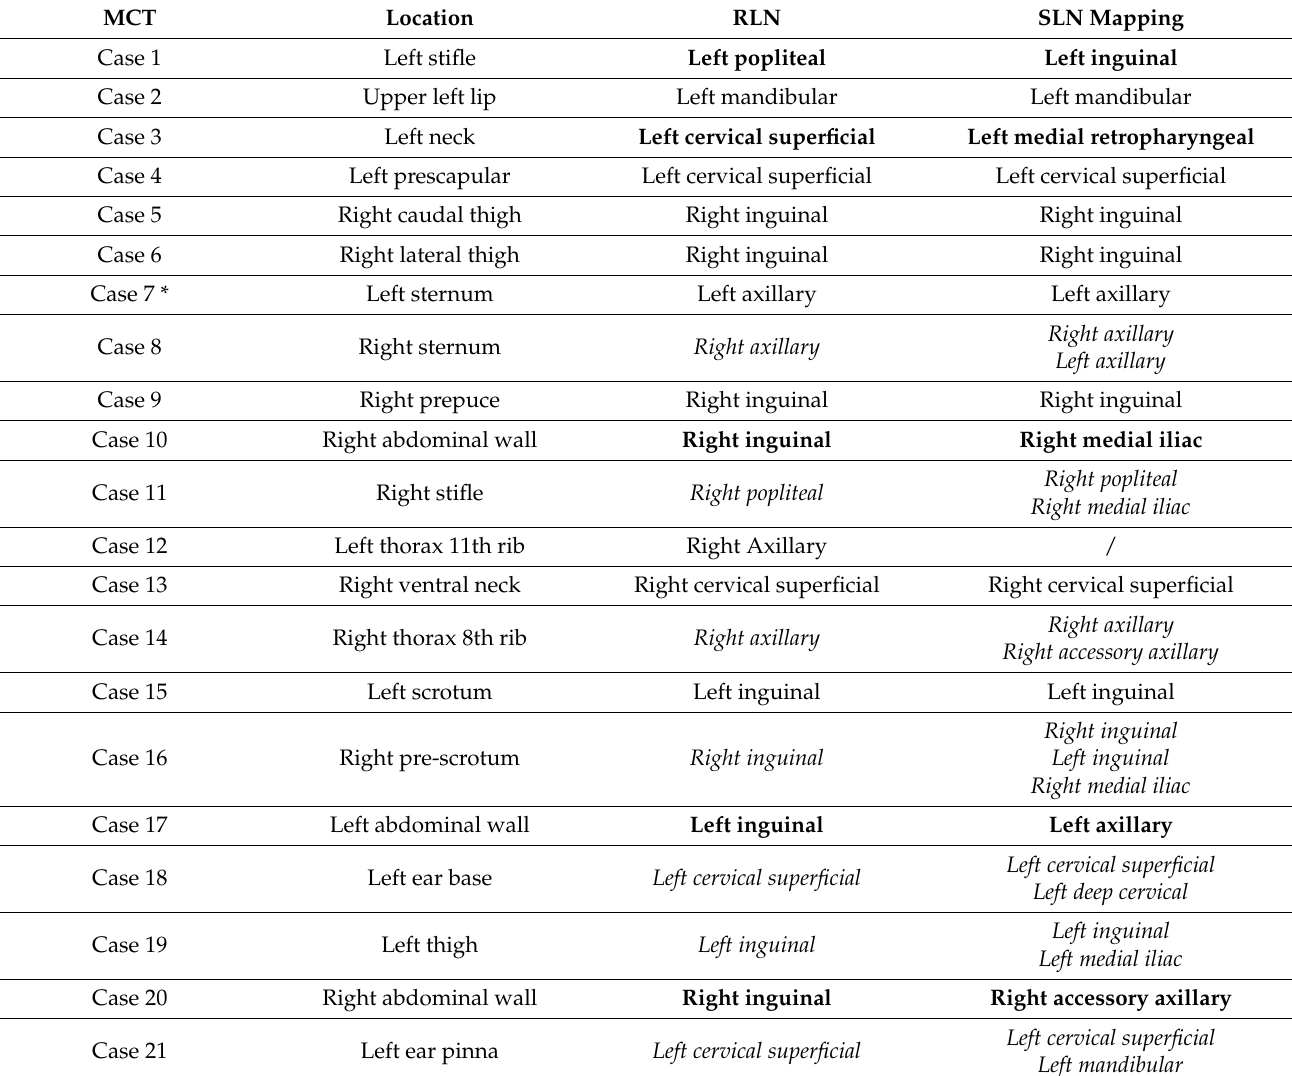
Table 2. Location of MTCs, RLNs, and SLNs assessed with indirect